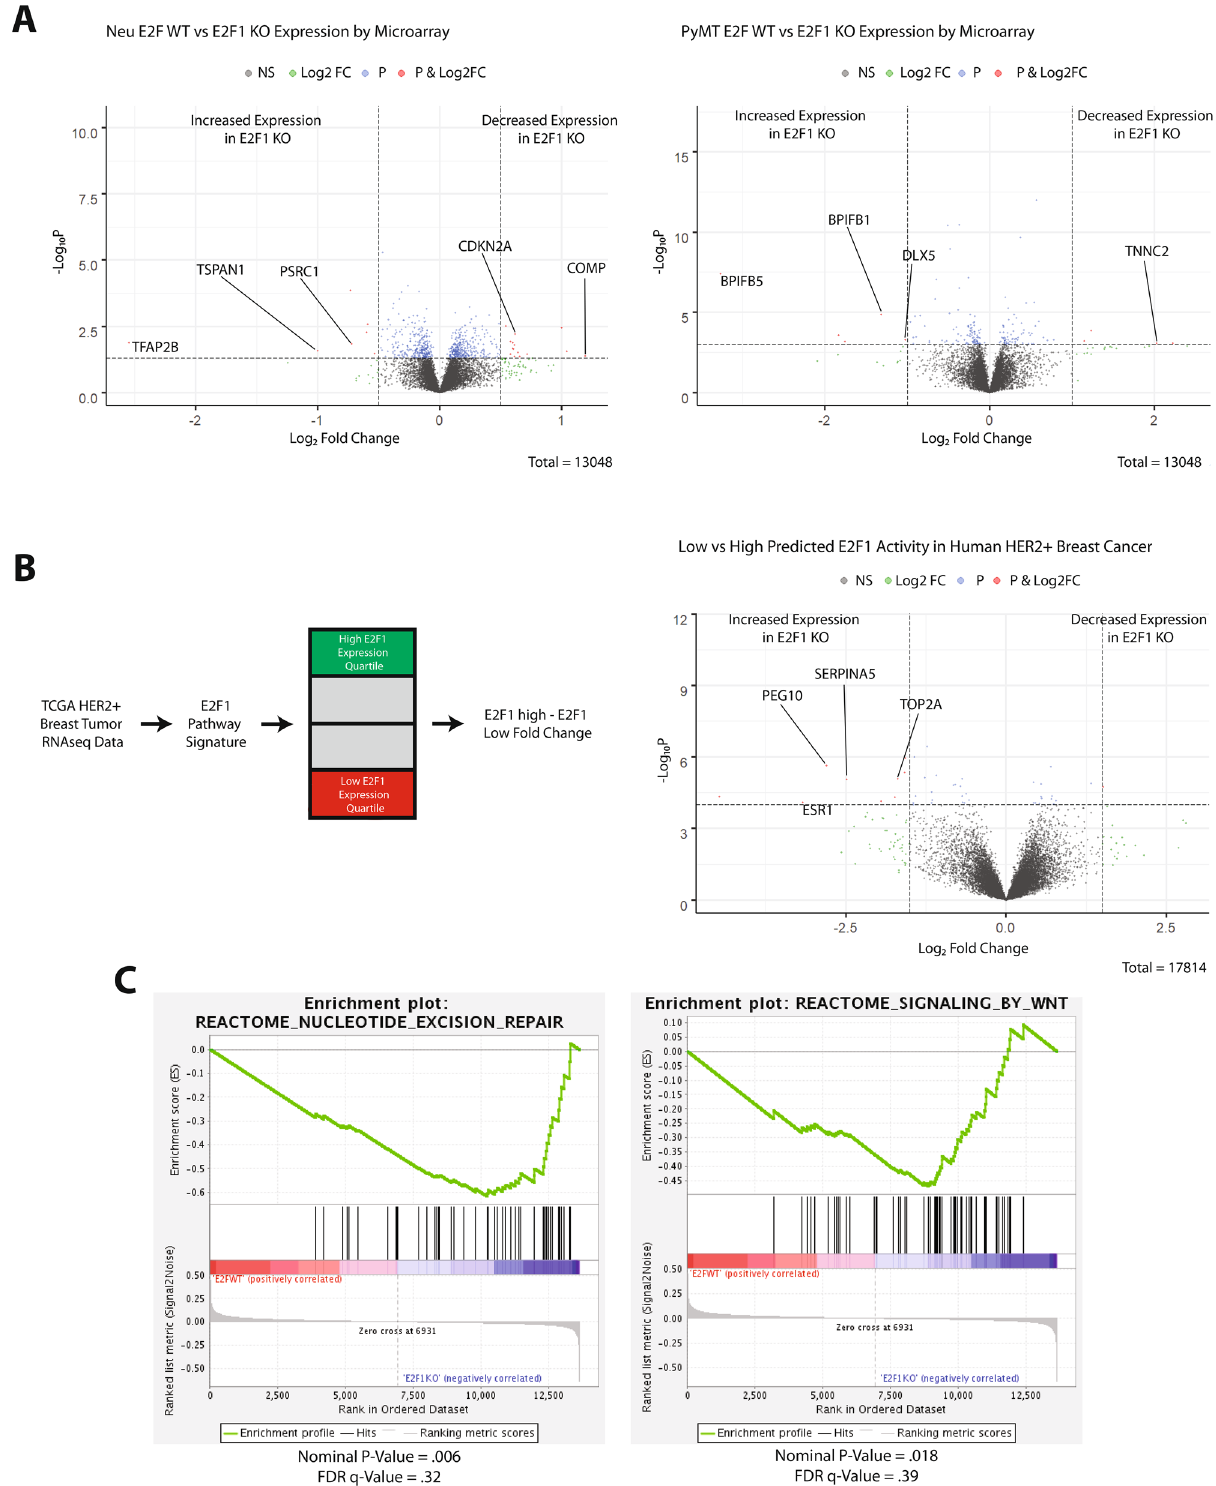
Figure 2. Gene expression changes in E2F1 −/− mouse tumors, and E2F1 low human breast cancer. ( A ) Two volcano plots show significant fold changes in genes from Neu and PyMT mouse tumors respectively. Fold change was determined by subtracting the E2F1 KO mean from the E2F1 WT mean for each gene. Fold change and p value cutoff for Neu tumors was .5, and .05 respectively. Fold change and P value for PyMT tumors was 1.0 and .001 respectively. ( B ) Diagram represents data processing steps for human TCGA data. A volcano plot shows significant fold change genes in E2F1 high versus E2F1 low human HER2+ve tumors. Fold change was determined by subtracting samples in the lowest E2F1 quartile mean from the highest E2F1 quartile mean for each gene. Fold change cutoff and p value for human tumors was 2.0, and 10e−60 respectively. ( C ) GSEA plots generated for E2F1 WT versus E2F1 KO tumors (Neu and PyMT combined) show enrichment of Nucleotide excision repair, and WNT signaling pathways in E2F1 KO